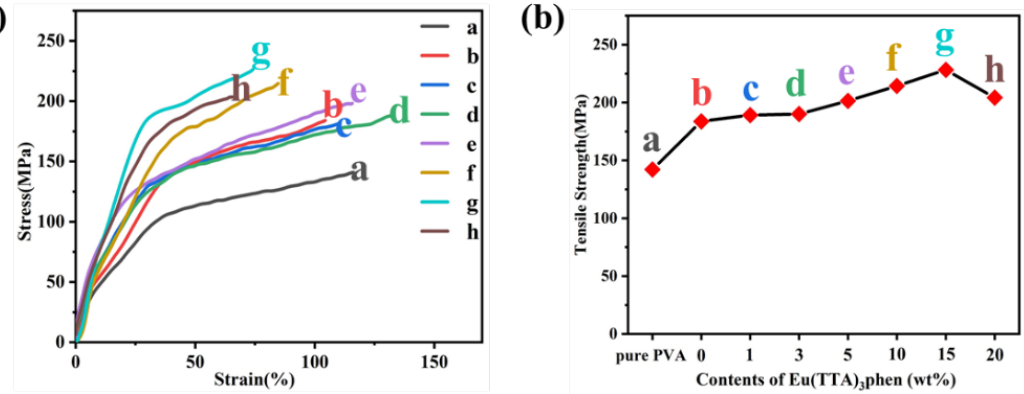
Figure 6. Strain-stress curves ( a ) and tensile strength change trend curve ( b ) of E-uMWCNT-Fs with different contents of Eu(TTA) 3 phen. The sample names in this figure are listed in Table 3. Table 3. Tensile strength and strain of E-uMWCNT-Fs with different contents of Eu(TTA) 3 phen. Sample Tensile Strength